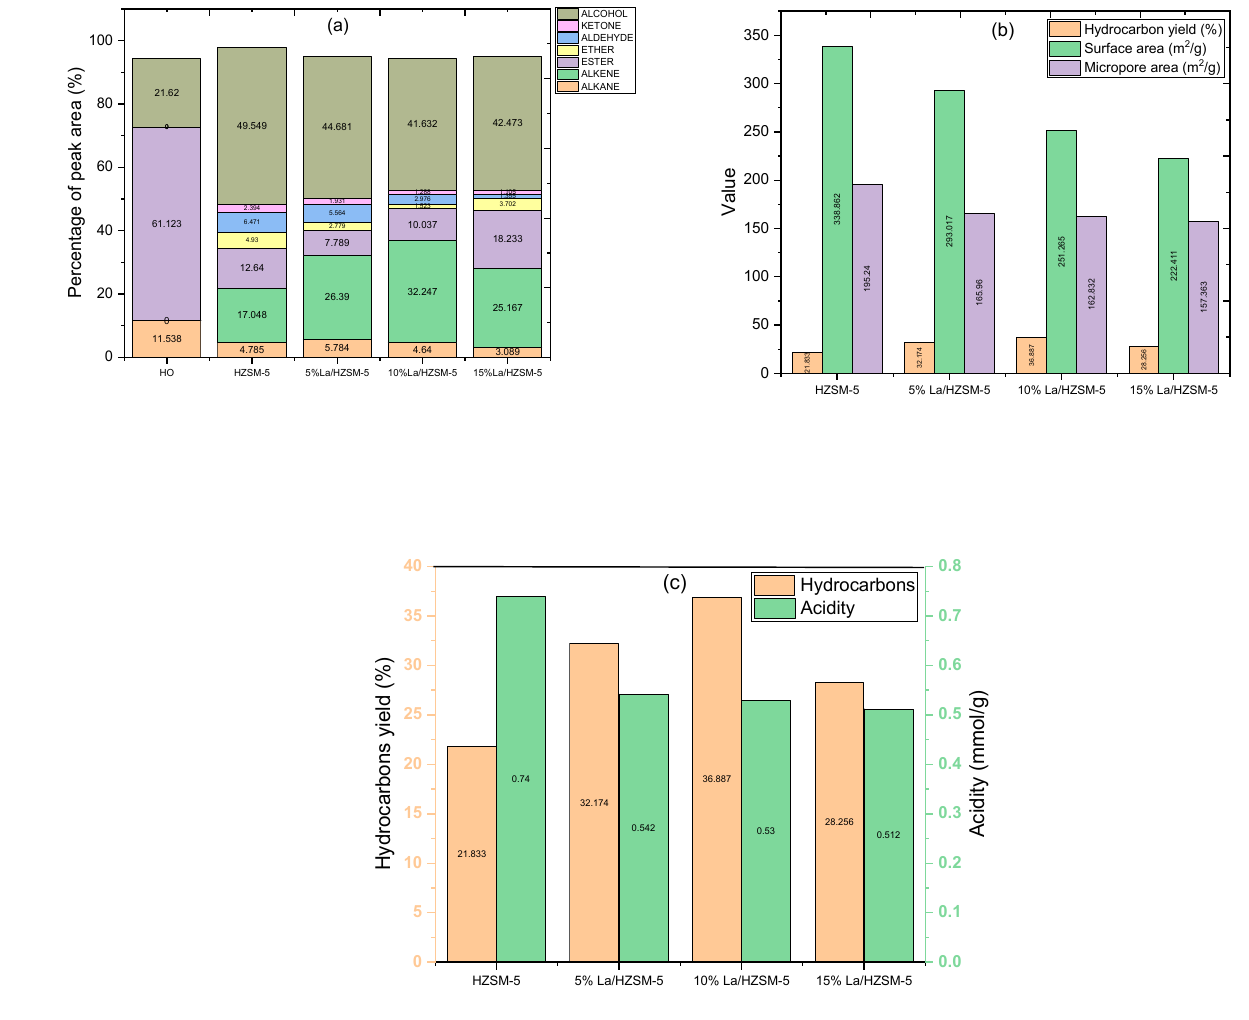
Figure 10. ( a ) The chemical composition groups of the algal HO and the liquid products from the catalytic deoxygenation of the algal HO over the parent HZSM-5 zeolite and lanthanum-modified HZSM-5 zeolite with different loading-weight percentage (batch reactor, 300 ◦ C, 1000 rpm, 7 bar N 2 , catalyst to algal HO ratio = 15% (wt.%) and 6 h), ( b ) hydrocarbon-yield percentage distribution with the surface area and micropore area of the synthesized catalysts, and ( c ) hydrocarbon-yield percentage distribution with the acidity of the synthesized catalysts. Table 4. The main components and content of the algal HO and the products of catalytic deoxygena- tion reactions for the algal HO over the parent HZSM-5 zeolite and lanthanum-modified HZSM-5 zeolite with different loading-weight percentage (batch reactor, 300 ◦ C, 1000 rpm, 7 bar N 2 , the catalyst to algal HO ratio = 15% (wt.%) and 6